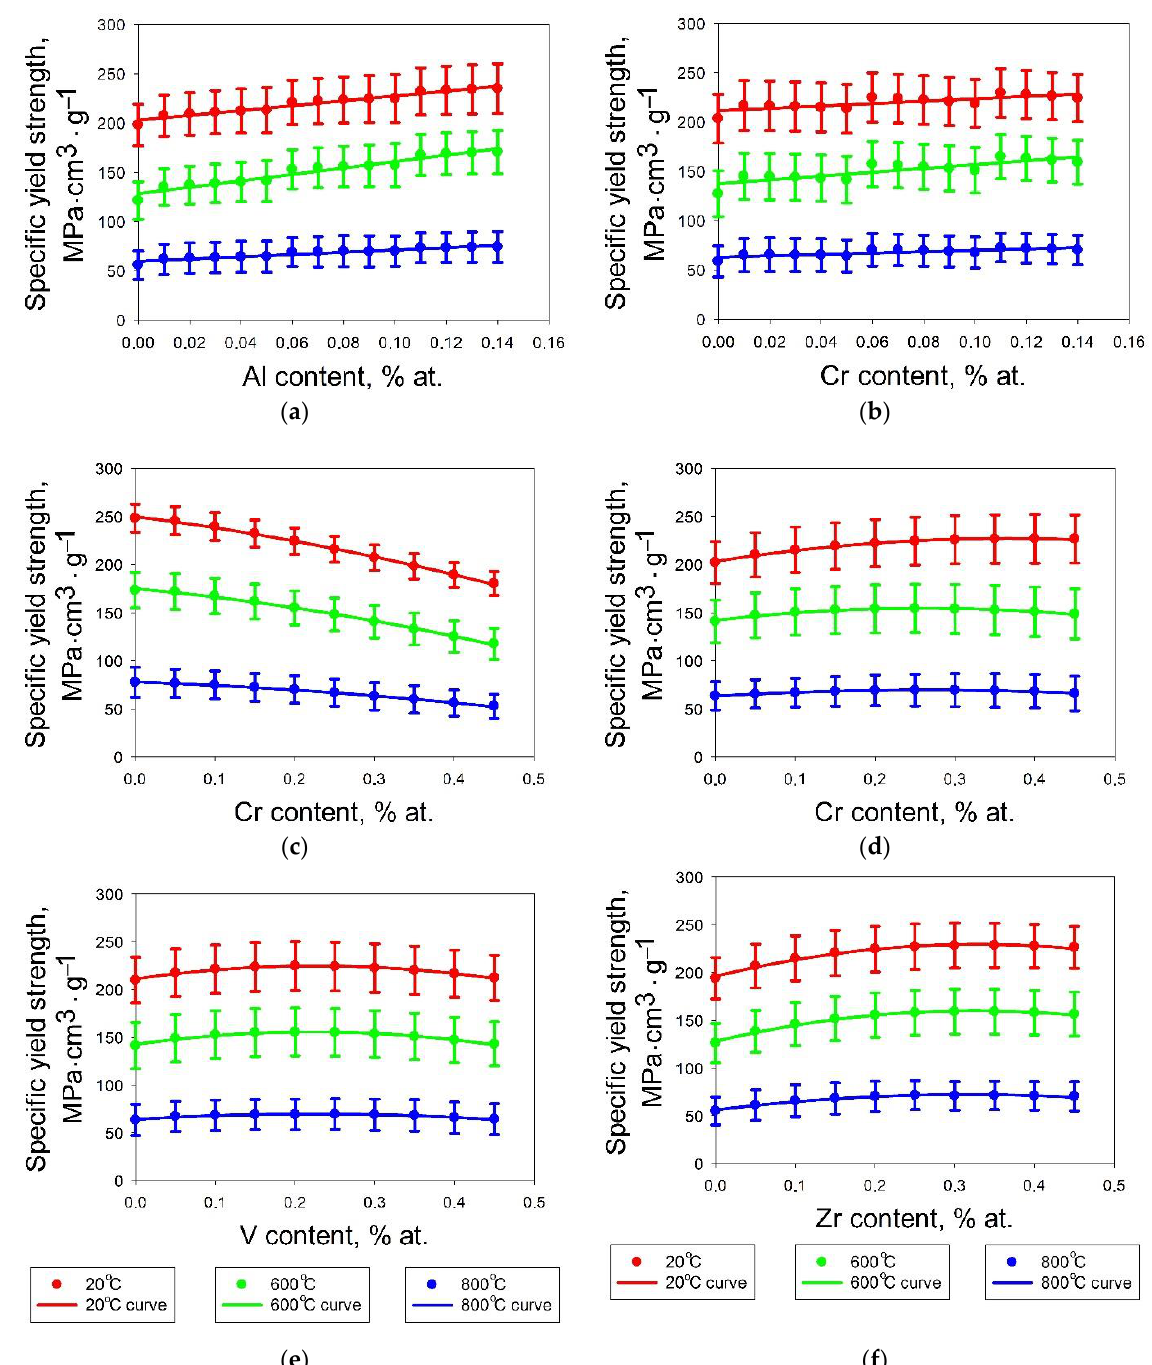
Figure 6. Dependence of mean specific yield strength on concentration of Al ( a ), Cr ( b ), Nb ( c ), Ti ( d ), V ( e ) and Zr ( f ).